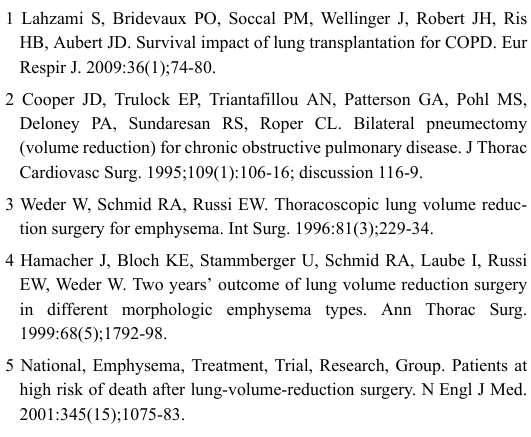
Table 5: EASE trial. Randomised design Therapeutic procedure